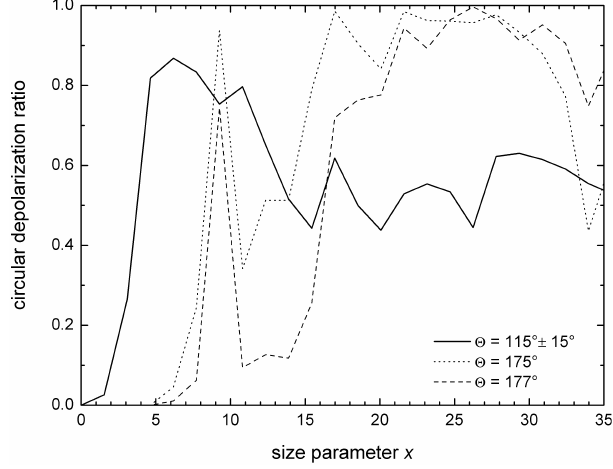
Fig. 3. Z 44 /Z 11 ratio for spherical particles as a function of the scattering angle 2 and the size parameter x . The refractive index n is 1 . 333 + 0 i .